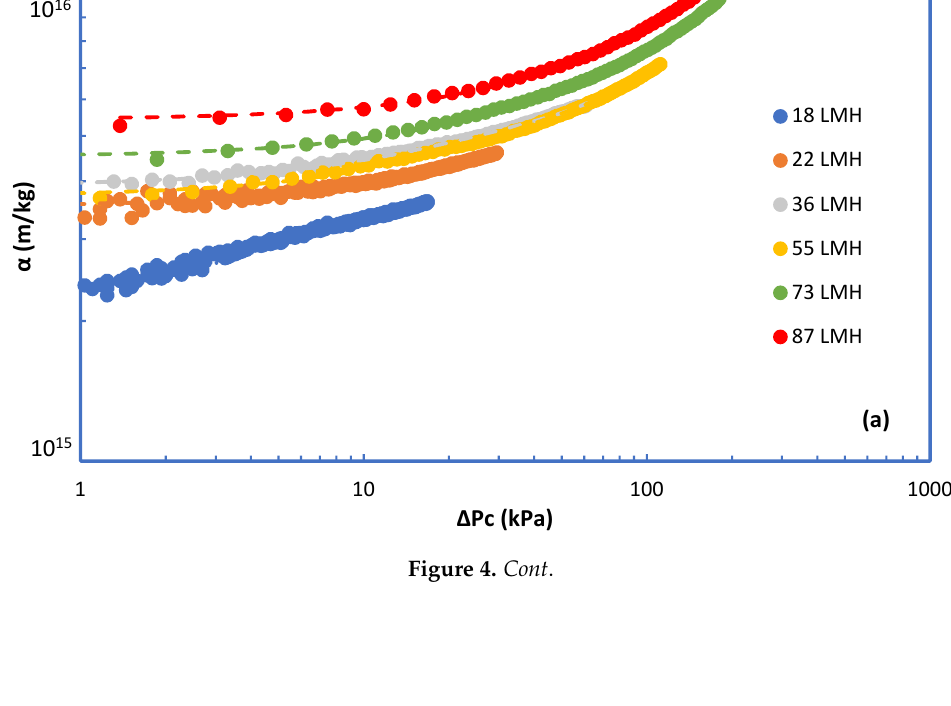
Figure 3. Variation of pressure drop due to fouling layer ΔP c versus permeate volume. Fouling species: ( a ) 100% ΒSA, ( b ) 75% SA-25% BSA.